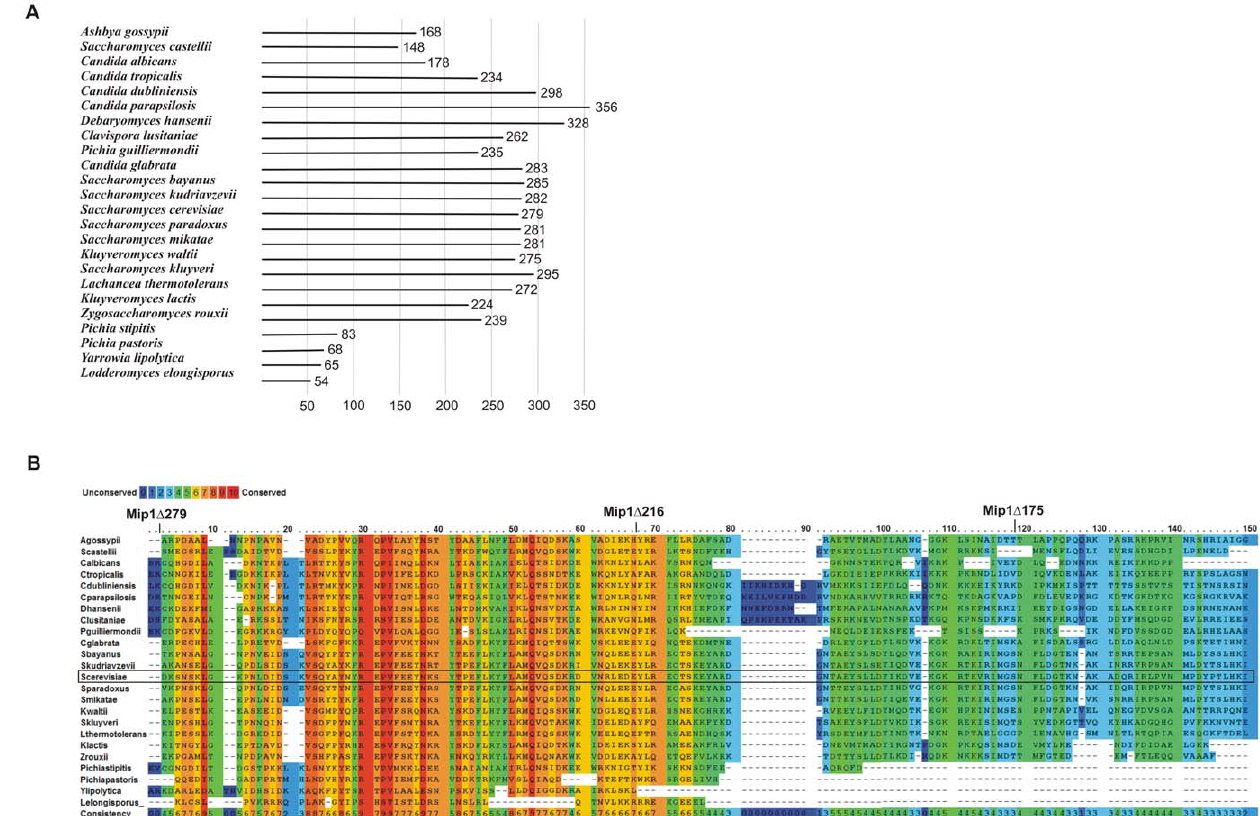
Figure 1. Length and amino acid sequence alignment of C-terminal extension of mitochondrial DNA polymerases from Saccharomycetes . A. Length of the CTE of Saccharomycetes species. The C-terminal extension was defined as the protein sequence starting from the 16 th amino acid past the c 6 motif. B. Amino acid sequence alignment of Saccharomycetes CTEs was performed with the PRALINE software available at www.ibi.vu.nl/programs [42] using the PAM250 weights matrix. Alignment of the first 150 residues is shown and the positions of S. cerevisiae Mip1 D 175, Mip1 D 216 and Mip1 D 279 deletion mutants are indicated.